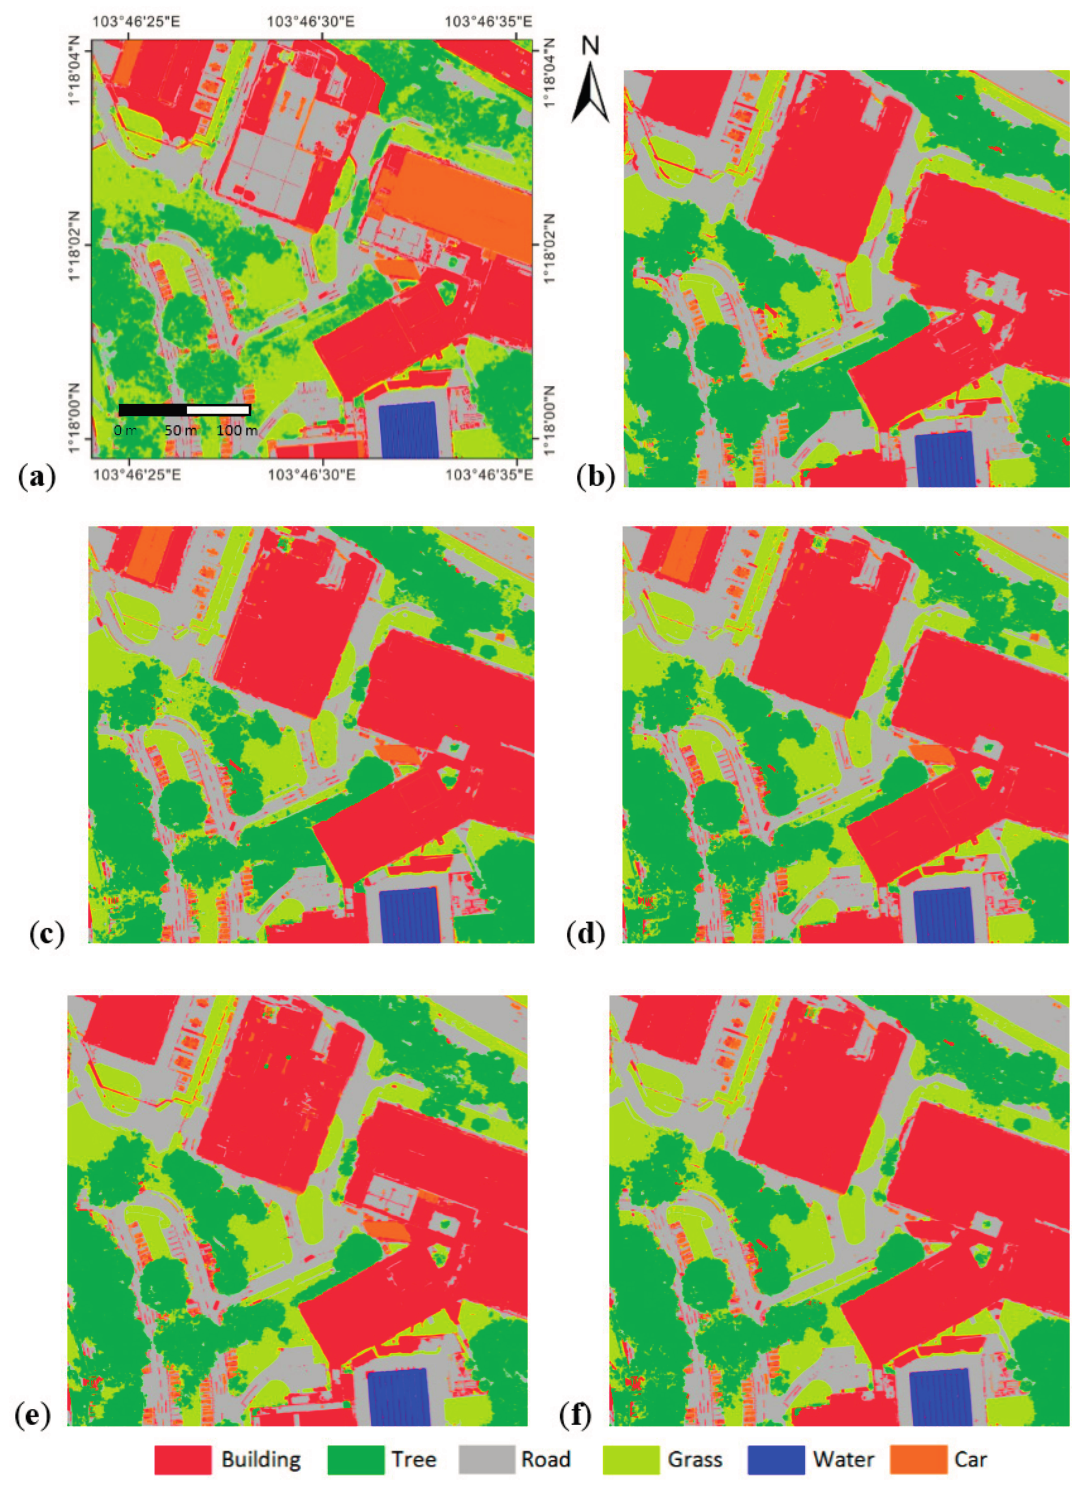
Figure 9. The classification maps of Test Dataset 2 using PCA combined with different spatial features. ( a ) Using spectral features only (PCA); ( b ) PCA + DMP; ( c ) PCA + height; ( d ) PCA + nDSM; ( e ) PCA + DMTHP with a regular interval radius sequence; ( f ) PCA + DMTHP with adaptive radius